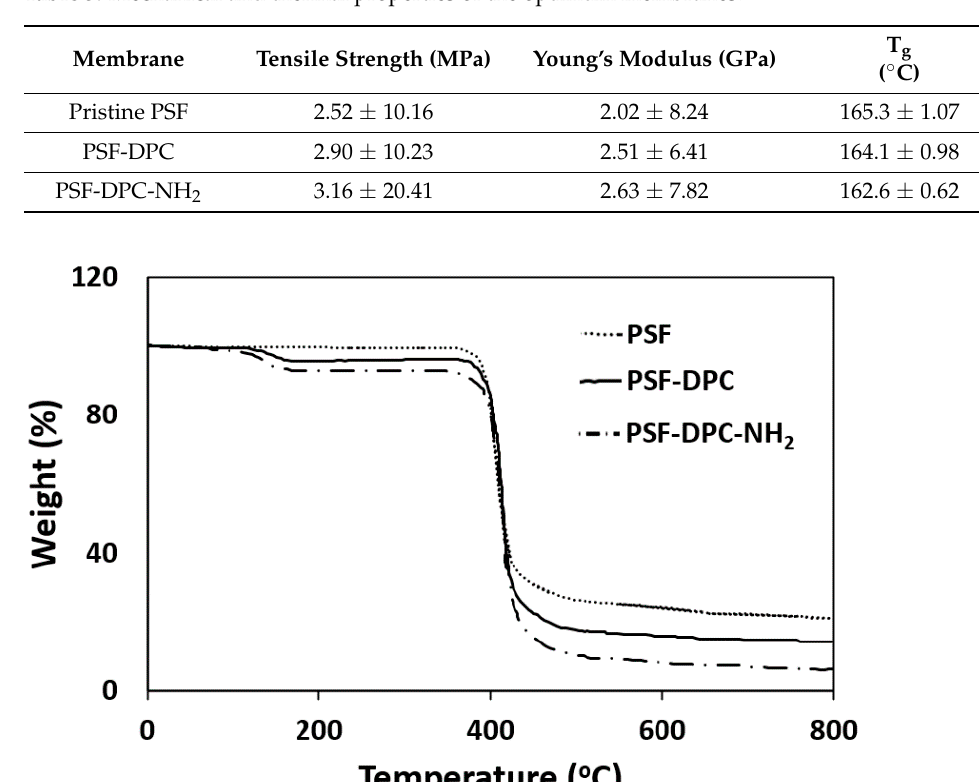
Figure 10. TGA thermogram of optimum coupled pristine PSF and composite PSF incorporated with DPC and DPC-NH 2.